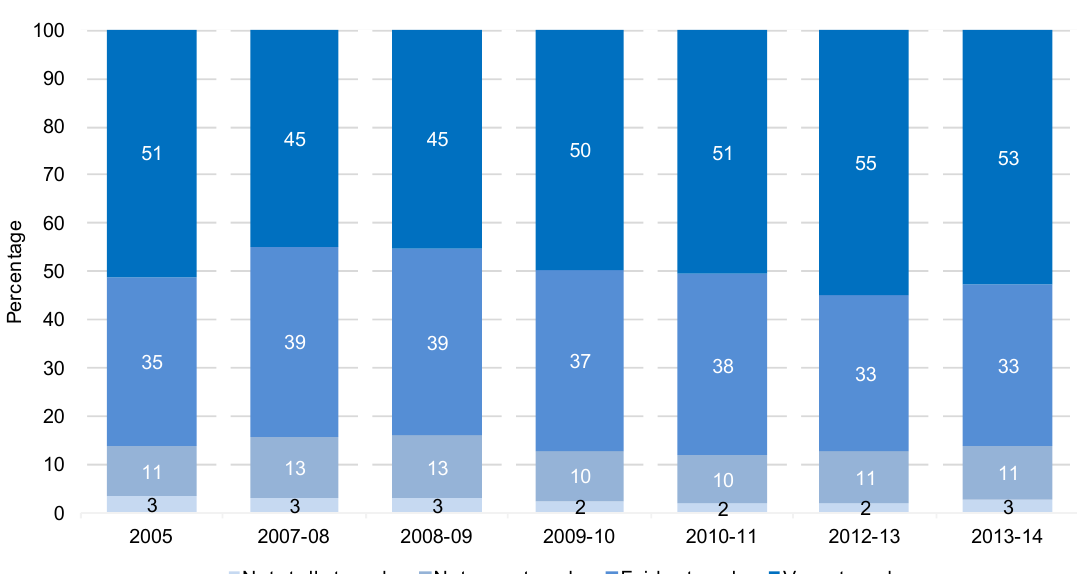
Figure 14: Proportion of people who feel they belong strongly to Britain, 2003 to